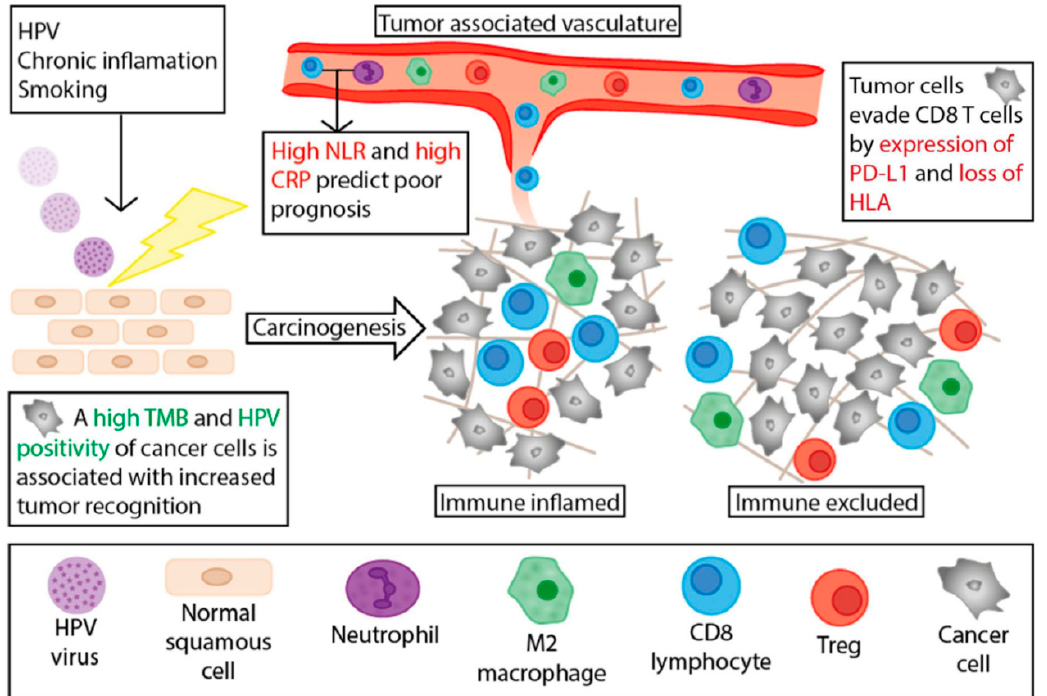
Figure 1. Illustrates tumor microenvironment in penile cancer (Reprinted with permission for Elsevier from “Defining the Tumor Microenvironment of Penile Cancer by Means of the Cancer Immunogram”, by Hielke-Martijn de Vries et al., European Urology Focus, September 2019). Abbreviations: Treg = regulatory T cells, HPV = human papillomavirus; TMB = tumor mutational burden; NLR = neutrophil-to-lymphocyte ratio; CRP = C-reactive protein, PD-L1 = programmed death-ligand 1 [25].